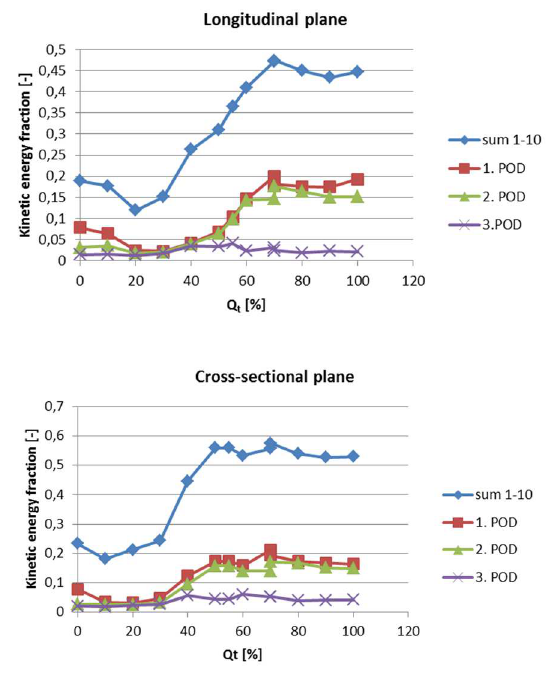
Fig. 5a,b. Kinetic energy fraction of low-order modes for both planes of measurement in dependency on tangential flow rate